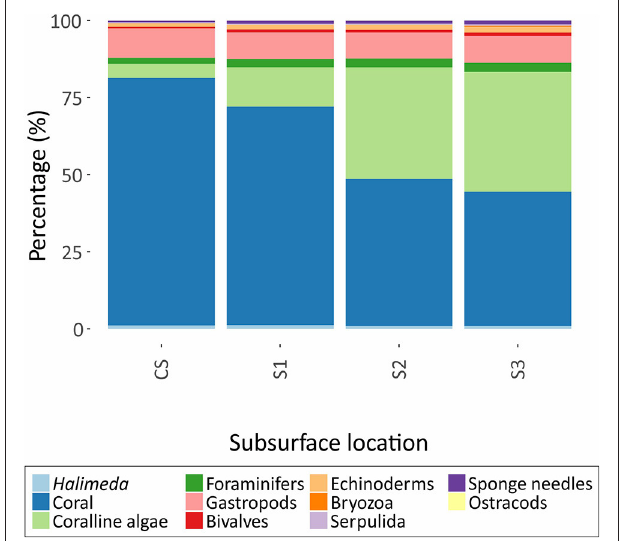
FIGURE 6 | Bar chart indicating the mean percentage of subsurface sediment composition from the different sampling localities on P.